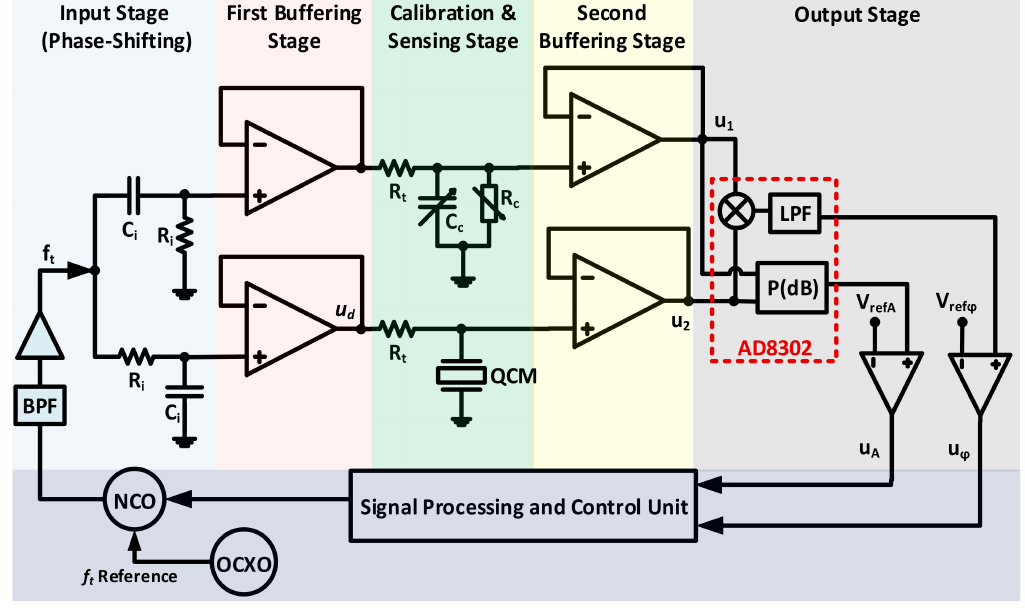
Figure 24. Circuit diagram of the practical phase-mass characterization implementation from